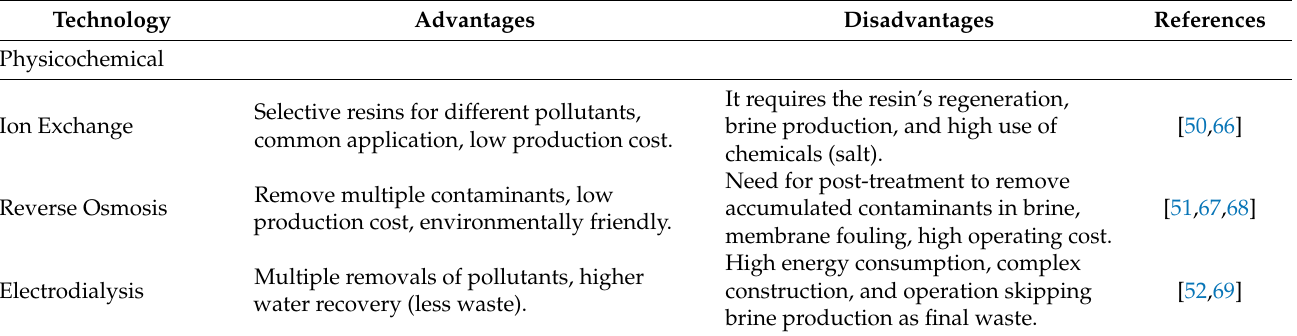
Table 1. Comparison of different nitrogen removal techniques (modified from